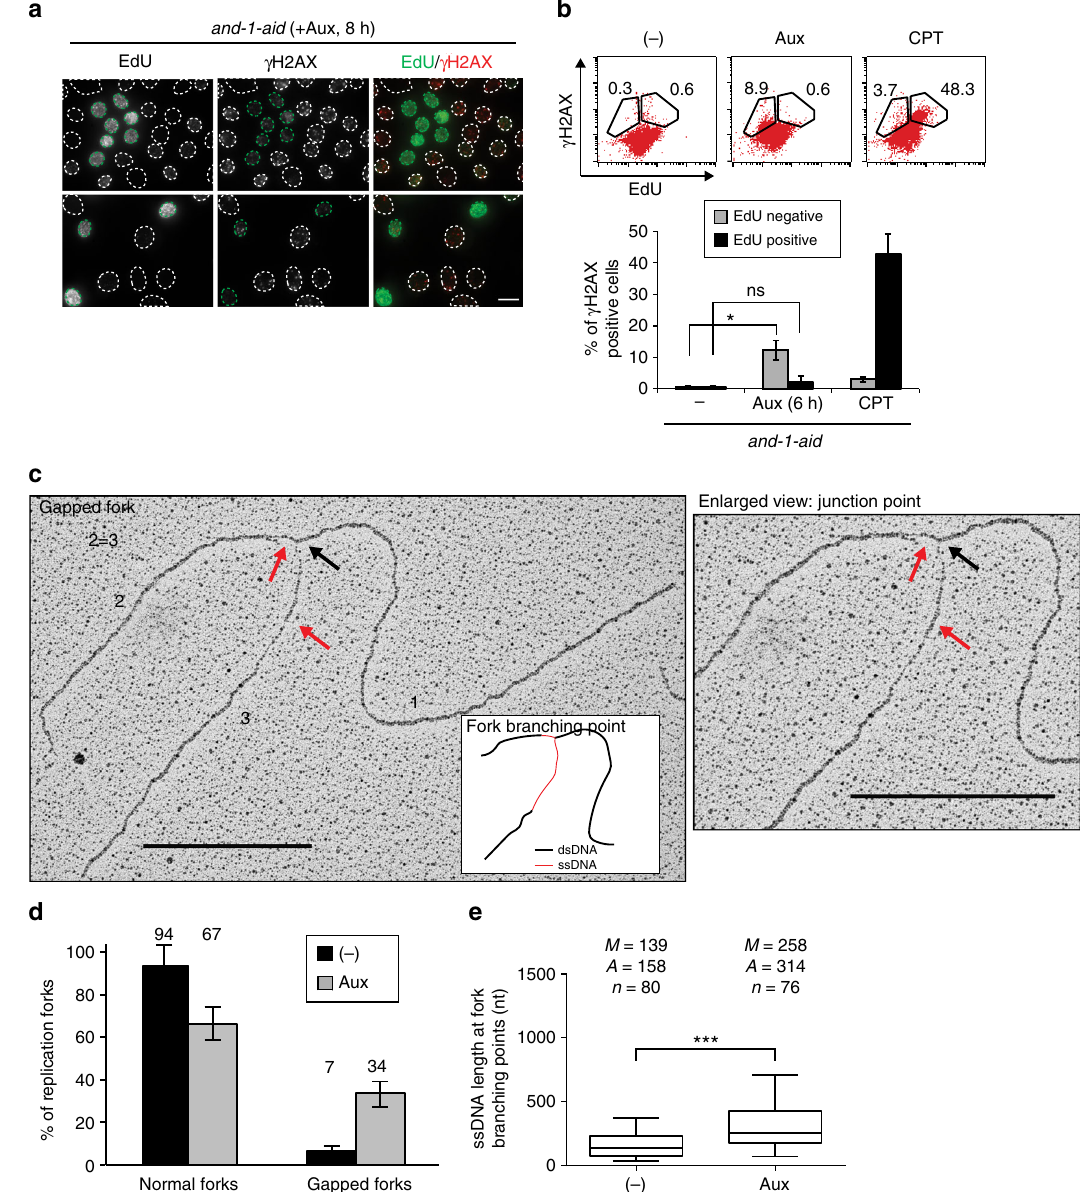
Fig. 3 AND-1 depleted cells accumulate ssDNA at replication forks and DSBs in G2. a , b and-1-aid cells were cultured with auxin for 8 h, and incubated with EdU for 15 min. In case of CPT treatment, 10 μ M CPT was added for 6 h after EdU incorporation and cells were incubated for 5 min. Cells in S phase or with DSBs were detected by Click-iT method or immnostaining with anti- γ H2AX antibody. a Scale bar represents 10 μ m. b Error bars represent standard deviation (SD) from three independent experiments. c – e and-1-aid cells were incubated with or without auxin for 4 h. Replication intermediates (RIs) were analyzed by transmission electron microscopy (TEM). c Representative TEM pictures (complete view and magni fi ed image of the fork junction point) of a DNA replication fork with a single strand DNA discontinuity. The numbers 1, 2, 3 mark the three arms of the replication fork, with two arms, 2 and 3, being equal in length, using a 10% tolerance in measurements. For each TEM picture, 360 nm scale bars, corresponding to the length of 1 kb of DNA is shown. Red arrows point to the ssDNA fi lament, the black arrow to the fork branching point. A schematic representation of the junction point is shown, with dsDNA in black and ssDNA in red. d Chart and numbers above showing the percentages of replication forks analyzed in the indicated genetic backgrounds (the reported gapped forks have ssDNA > 300 nt). Molecules derive from two independent experiments, for a total number ( n ) of molecules shown in panel e . Error bars represent the SD obtained from two independent experiments. e Box plot reporting the distribution of ssDNA length at fork branching points. n is the total number of replication forks analyzed, A is the average length of ssDNA, and M is the median length of ssDNA. In the box plots, the middle line indicates the median value; the box shows the 25th and 75th percentiles; the bars, the 5th and 95th percentiles. P values were calculated by Student ’ s t -test. *** P ≤